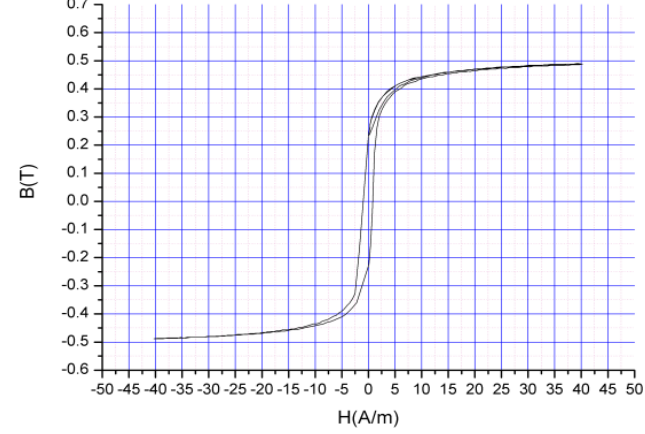
Figure 8. Hysteresis loop of magnetic core.